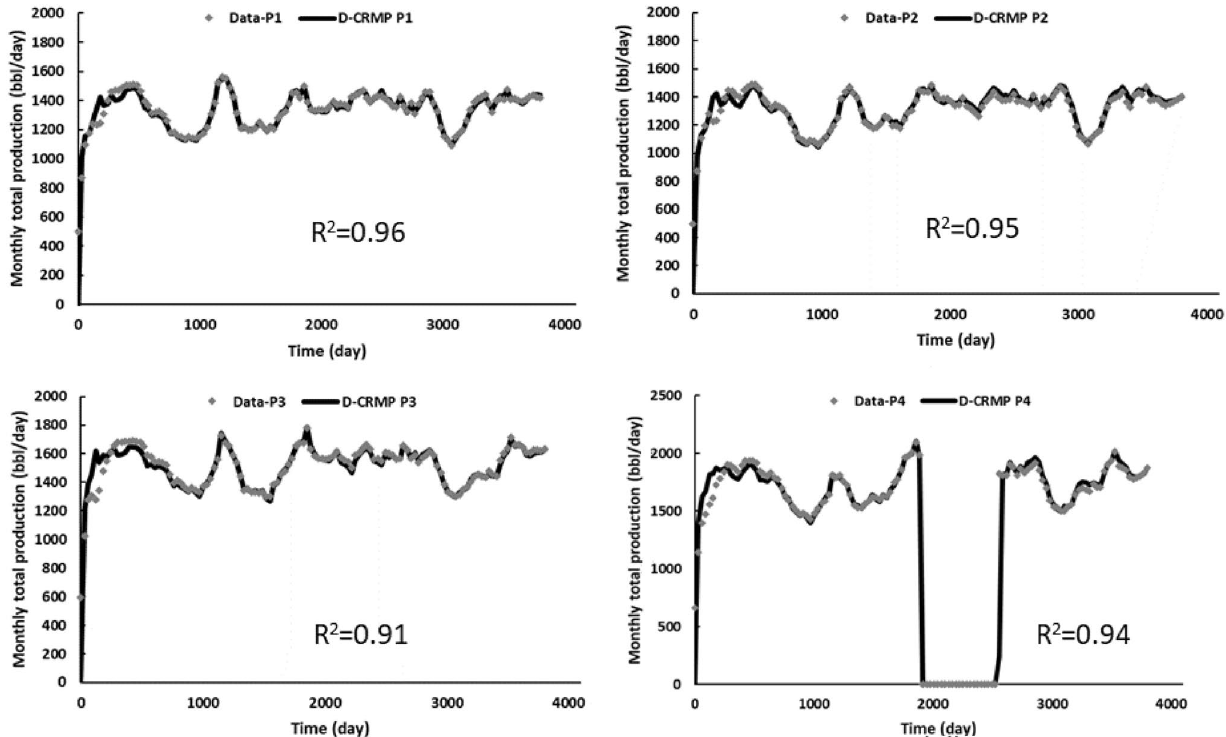
Fig. 26 Total production match by D-CRMP for all producers in case VI